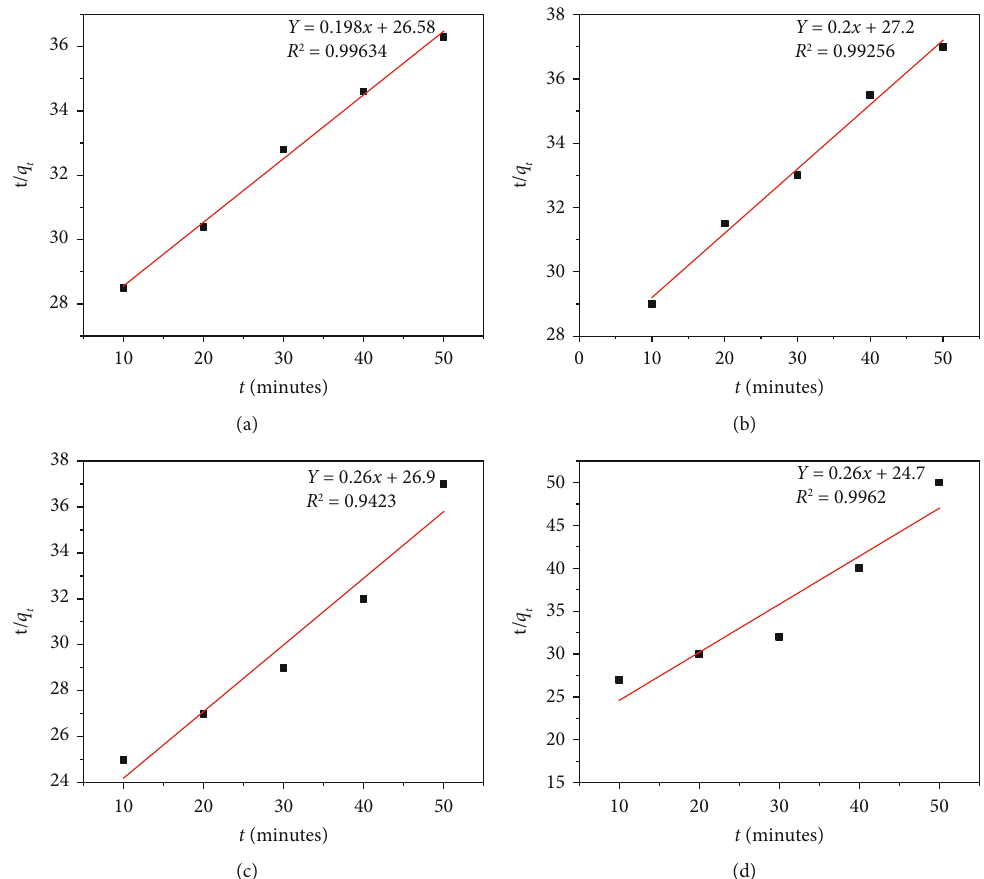
Figure 9: Pseudo-second-order plots for fl uoride adsorption by the adsorbents (a) TAADFP at 450 ° C, (b) TAADFP at 500 ° C, (c) TAADFP at 550 ° C, and (d) TAADFP at 600 ° C. Table 2: Desorption and resorption of fl uoride by TAADFPs activated at 450, 500, 550, and 600 ° C using distilled water and 0.1M NaCl (pH5, initial fl uoride concentration 5 mg/L, contact time 1 hour at room